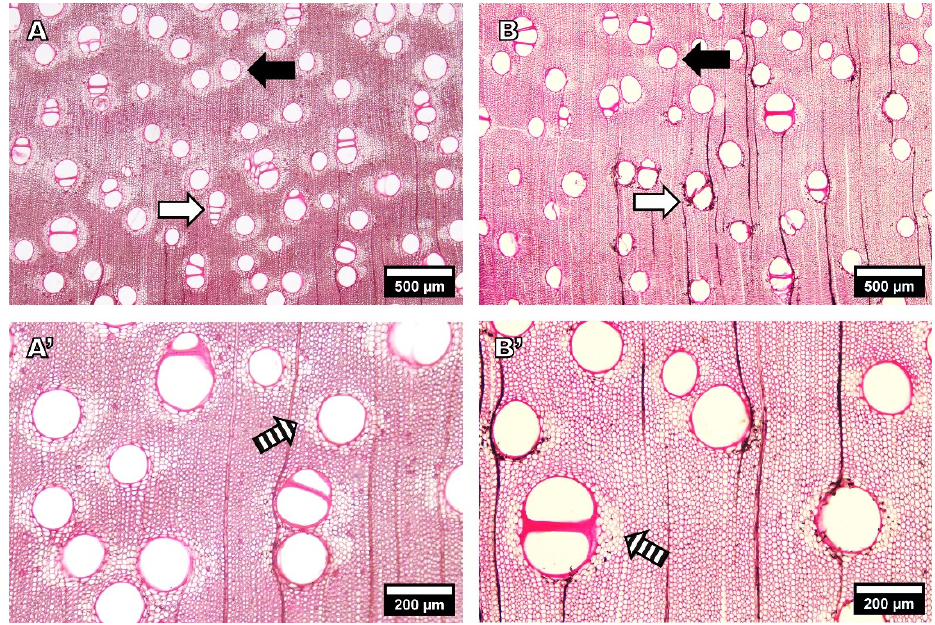
Figure 3. Optical micrographs of the cross-sections of Acacia mangium ( A , A’ ) and Acacia hybrid ( B , B’ ). Solitary vessel (black arrow), radial multiple vessel (white arrow), and axial parenchyma (striped arrow).